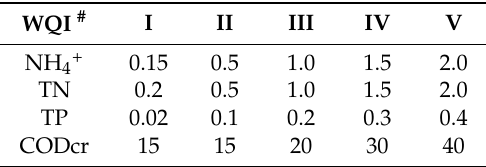
Figure 3. The spatial variation of COD, NH 4 + , TN and TP in Chengdu segment of Tuojiang River watershed. Table 2. The surface water quality (mg/L)